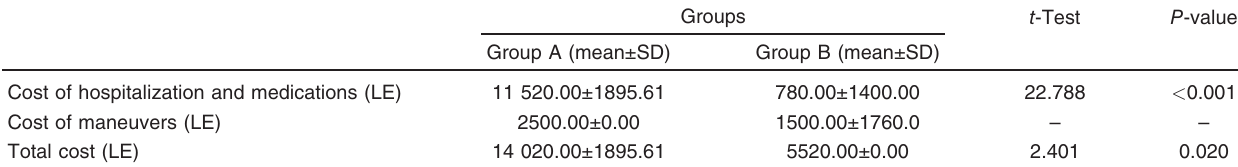
Table 4 Comparison of cost of hospital and medication, maneuver, and total cost in groups A and B